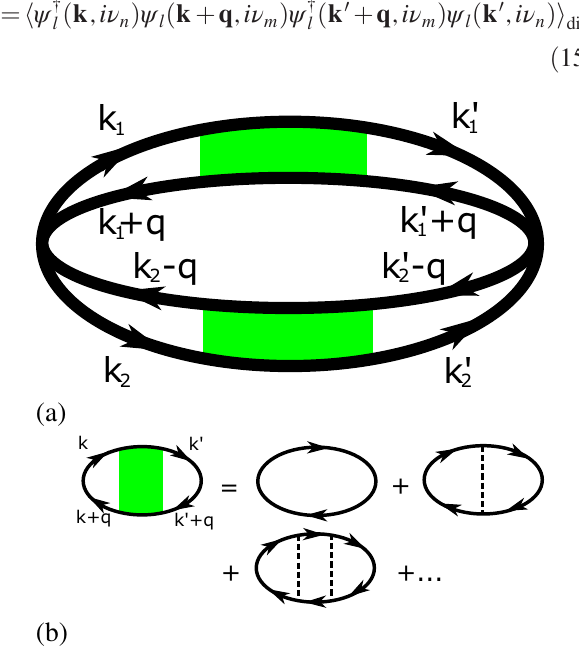
FIG. 2. (a) The thermal current – thermal current correlation diagram. The Green ’ s functions on the top, which are functions ofmomentum k 1 ,arerelatedtolayer l ,whilethose onthebottomare from layer l 0 . Note that the current vertex consists of four Green ’ s functions,twofromeachlayer.(b)Thedisorder-averagedfour-point correlator within each layer, ϒ ð k ; k 0 ; q Þ . The black lines denote fully dressed fermionpropagators, dashed lines represent the effects of disorder, the squiggly lines are the bare thermal current vertex, and the green area stands for the fully renormalized two-particle vertex. We work in the self-consistent Born approximation, appli- l ≫ 1 , where only ladder diagrams are taken into cable for k F account. We suppress the frequency dependence for